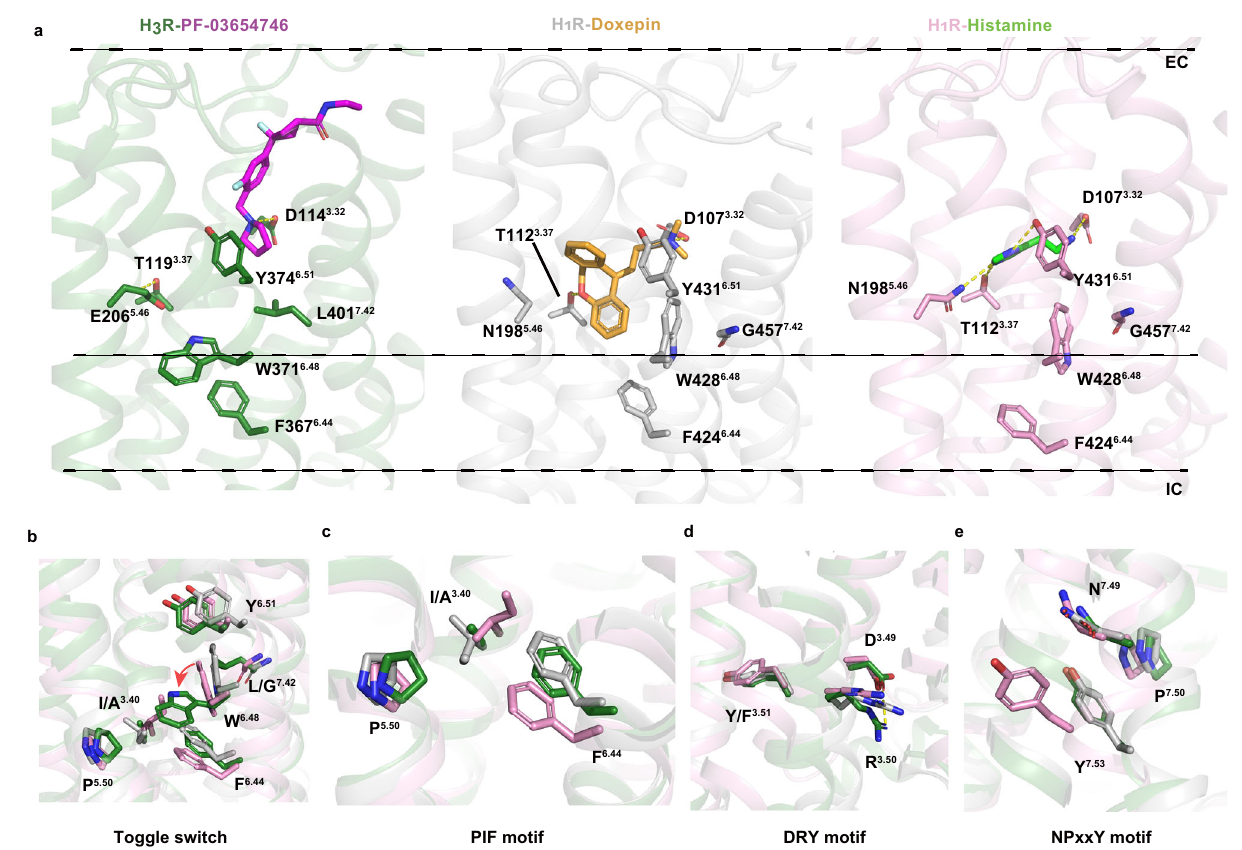
Fig. 4 | Mechanism of H3R antagonism. a Superpositions of the ligand-binding pockets of H 3 R – PF-03654746 (H 3 R in forest green, PF-03654746 in violet), H 1 R – Doxepin (PDB ID: 3RZE, H 1 R in gray, Doxepin in yellow), and H 1 R –